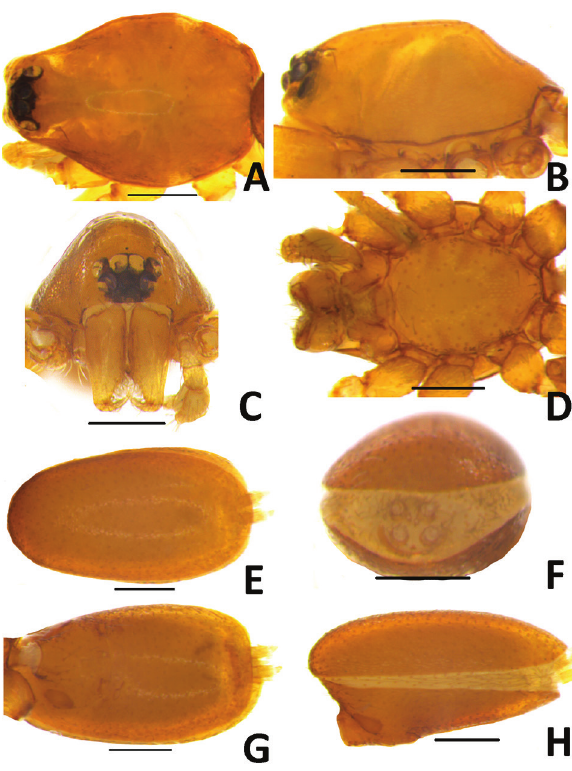
Figure 17. Silhouettella snippy n. sp., male from NIFS Arbore- tum: A , carapace, dorsal view; B , same, lateral view; C , same, anterior view; D , sternum, ventral view; E , abdomen, dorsal view; F , same, posterior view; G , same, ventral view; H , same, lateral view. Scale bars: 0.2